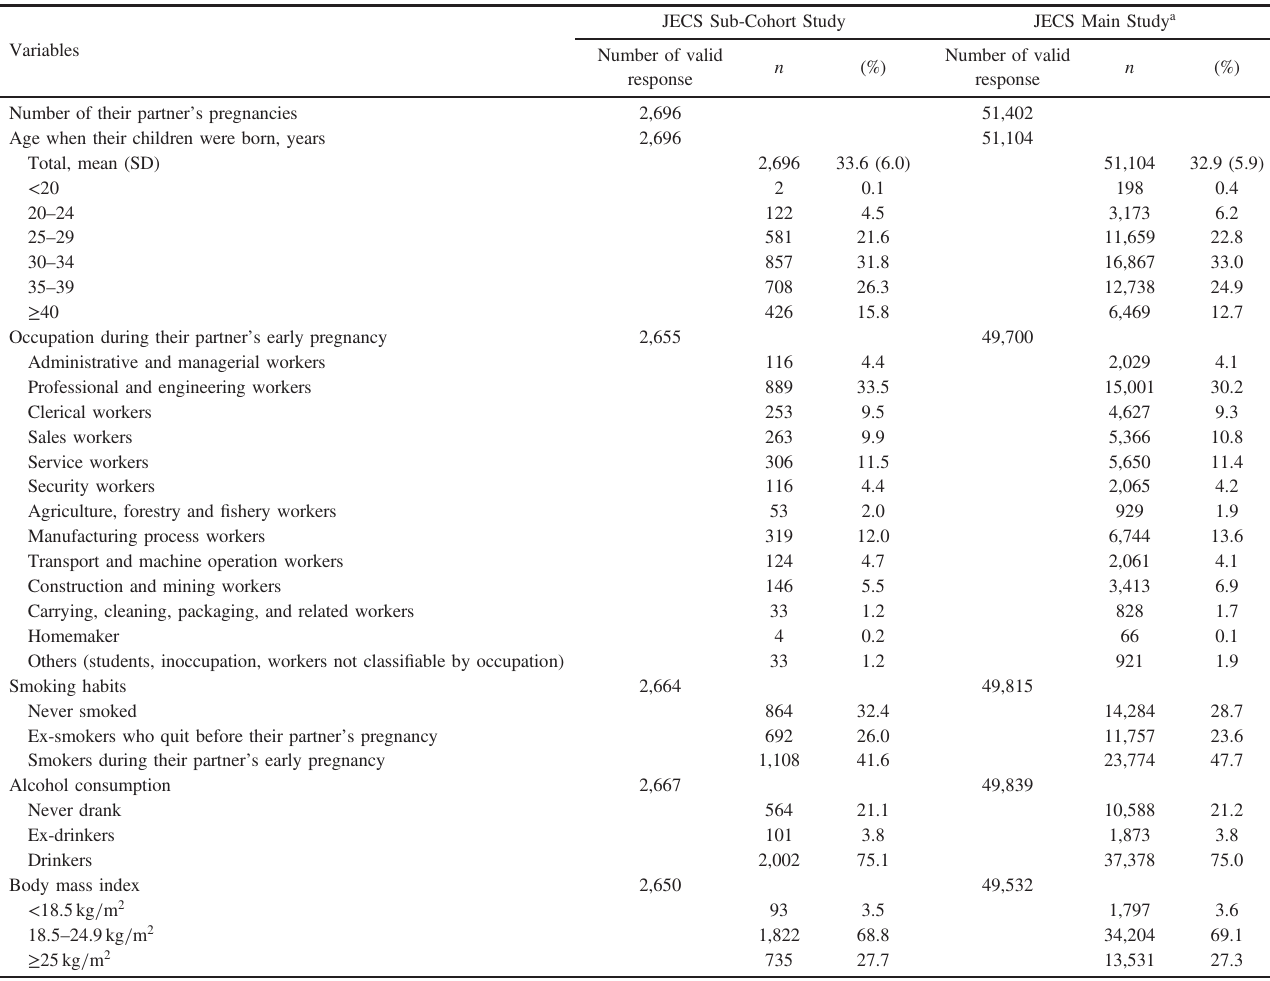
Table 3. Baseline pro fi les of fathers in the JECS Main Study and Sub-Cohort Study Variables Number of their partner ’ s